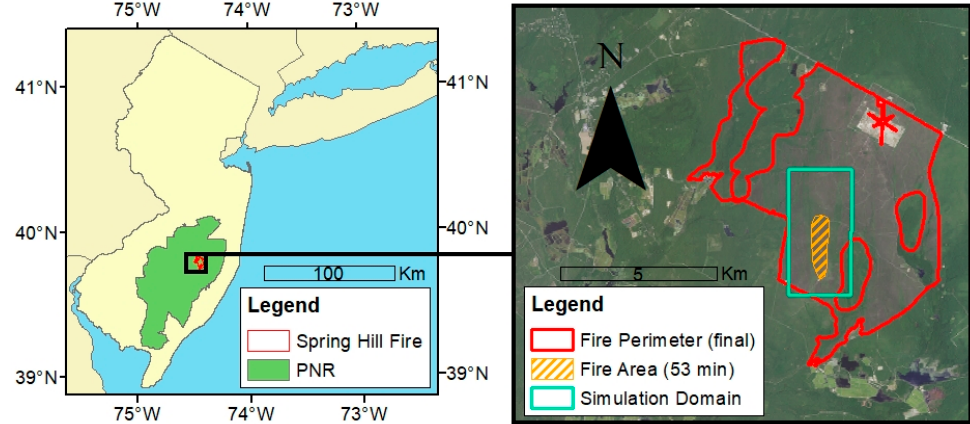
Figure 1. Spring Hill Fire location in the PNR ( left ). Spring fire perimeter at 53 min following ignition (estimated from time of detection), final fire perimeter, QUIC-Fire simulation domain ( right ).